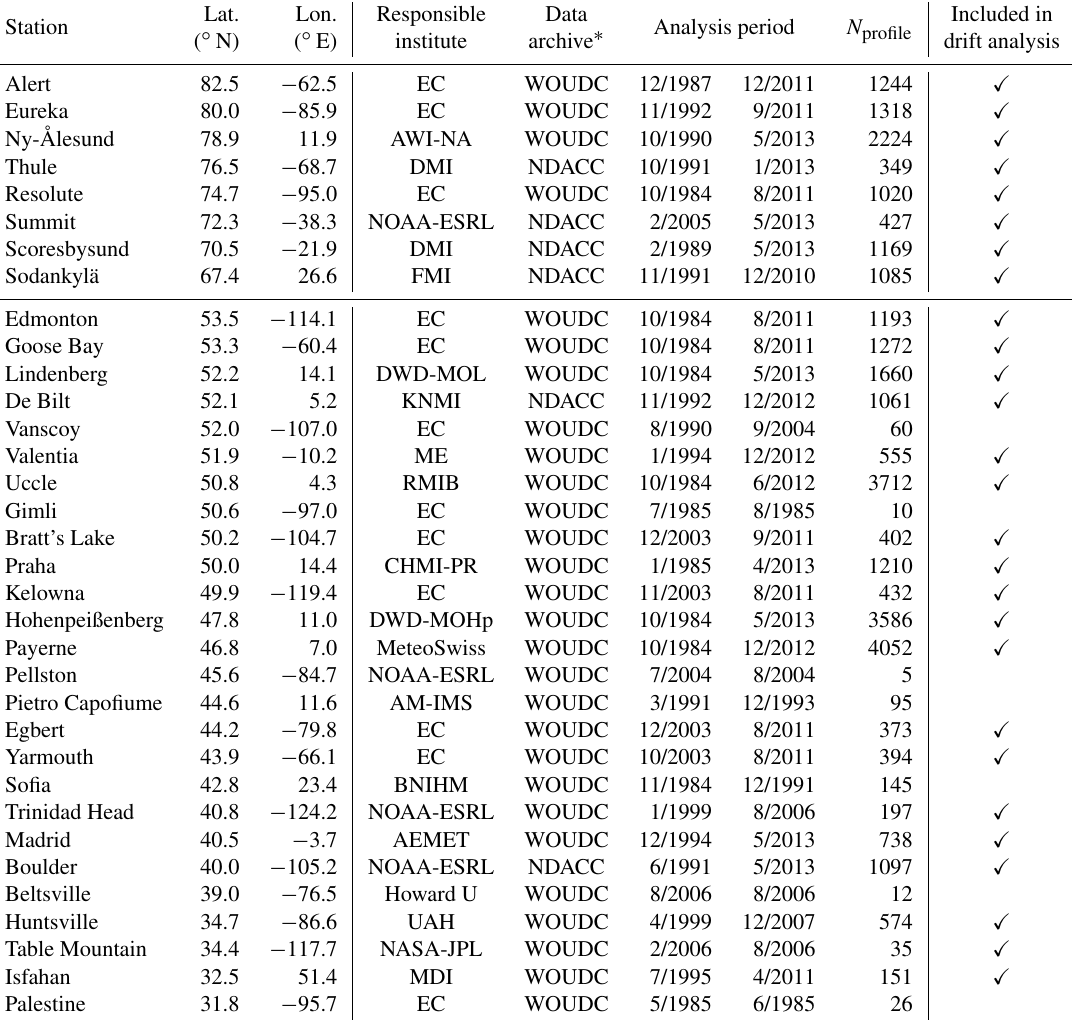
Table 1. Overview of the 72 ozonesonde stations considered in this work, their location and the archive the data were taken from. Time range and profile statistics reflect the total, screened sample straddling the analysis period (10/1984–5/2013), not the co-located sample (which differs per satellite instrument). All listed stations were used in the analyses of bias and comparison spread, those indicated in the last column were also used for the drift analysis.